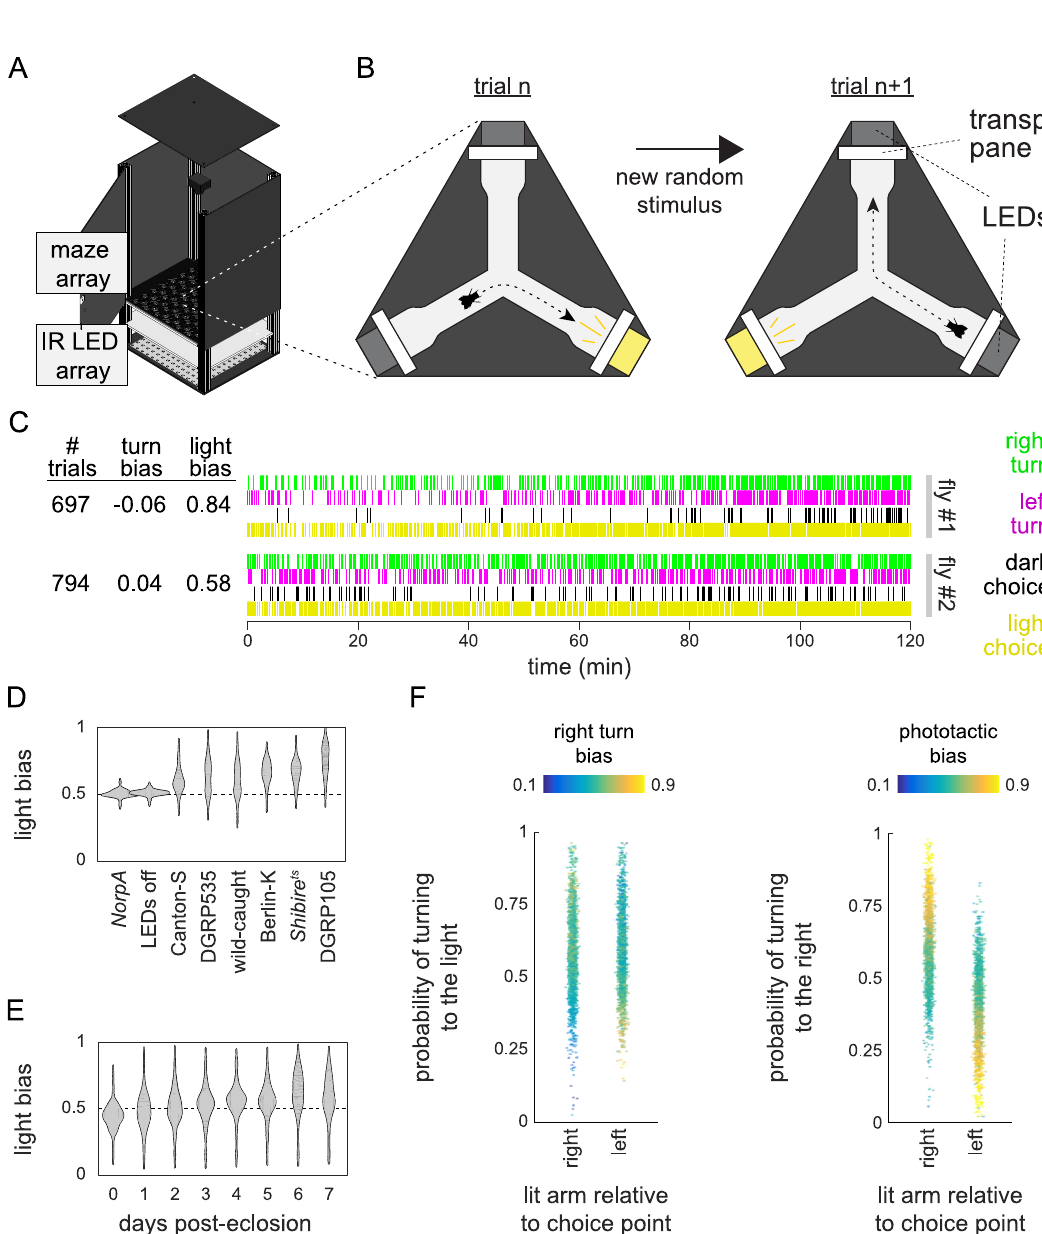
Fig 4. High-throughput phototactic assay in Y-shaped arenas. A) Schematic of the behavior box with an LED Y-maze array in place. B) Diagram of a single LED Y-maze and trial structure. New trials initiate by turning on (yellow) an LED in one of the two unoccupied maze arms. The trial ends when then animal turns into a new arm and the lit LED is turned off (gray). Each turn is scored for both handedness and phototactic preference. C) Raw turn data for two sample flies. Each individual trial consists of both a phototactic and handedness choice. Individual mean turn biases range from 0 (all left turns) to 1 (all right turns). Light biases range from 0 (all photopositive turns) to 1 (all photonegative turns). D) Comparison of individual average phototactic bias distributions for different wild-type fly lines. Blind flies (NorpA) and flies tested with all LEDs turned off (DGRP-105 dark) are included as negative controls. Horizontal dashed line indicates random bias at p = 0.5. E) Distribution of individual average phototactic biases for the same cohort of flies over the first 8 days post-eclosion. F) Individual mean phototactic and right turn biases calculated on all trials sub-divided by into trials where the lit arm of the maze was to the right or left of the choice point. Data points are colored by either the individual mean right turn bias (left panel) over all trials or the individual mean phototactic bias (right panel) over all trials. The rank orders of both turn bias and phototactic bias are anti-correlated (r = -0.38 and -0.63 respectively) between trials where right or left arm was